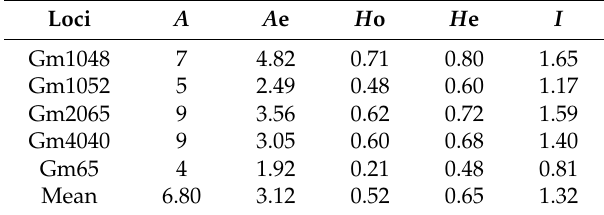
Table 4. Genetic diversity of 11 populations of Erythorphleum fordii at species level. Loci